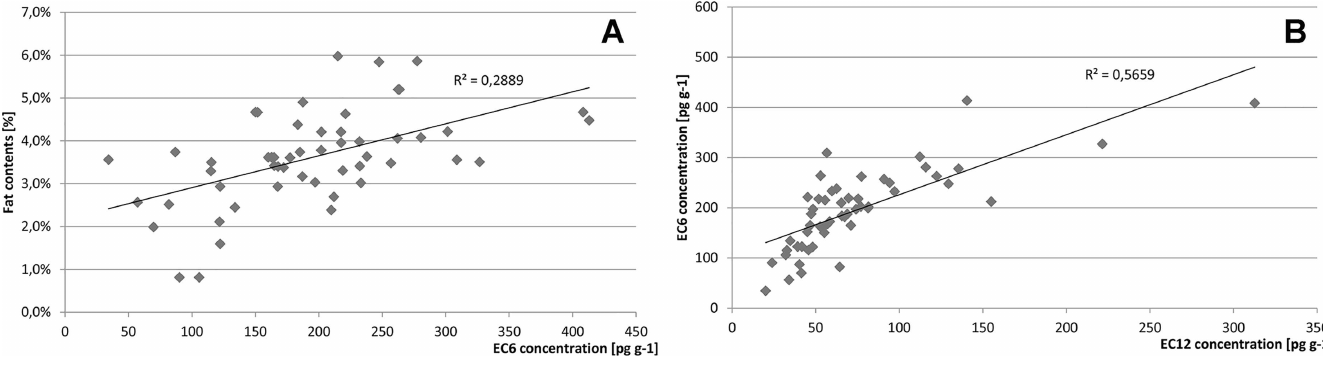
Fig 4. Relationship betweenlipid contents and EC6 concentrations (A) and betweenEC6 and EC12 concentrations (B) in the analyzedsamples of bee